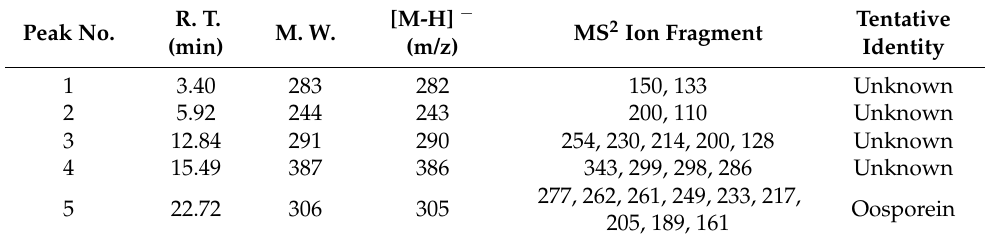
Table 3. Kinetic parameters of Beauveria bassiana PQ2 under biofilm bioreactor conditions. Peak